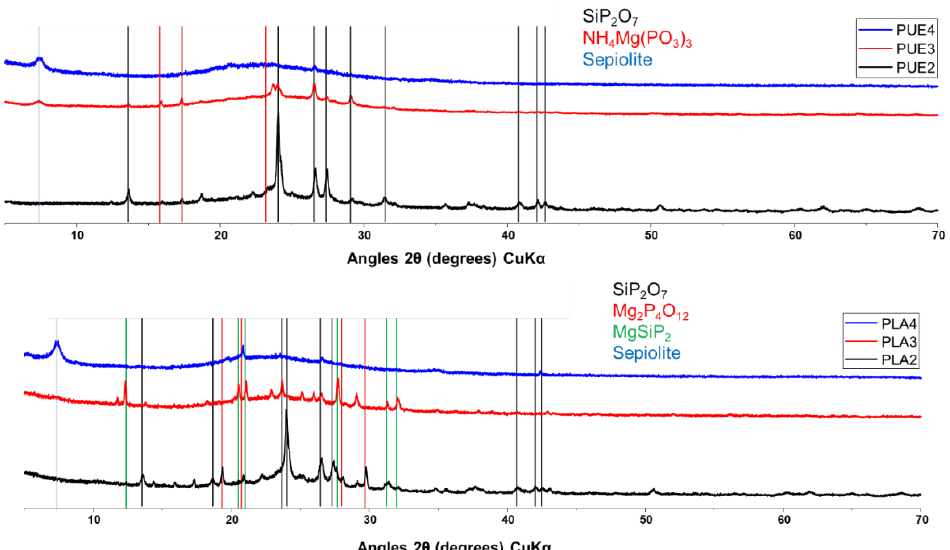
Figure 18. XRD patterns for PLA / APP / S9 and PUE / APP / S9 composites residues. (The colors of the vertical lines are in agreement with those of the compounds identified.)